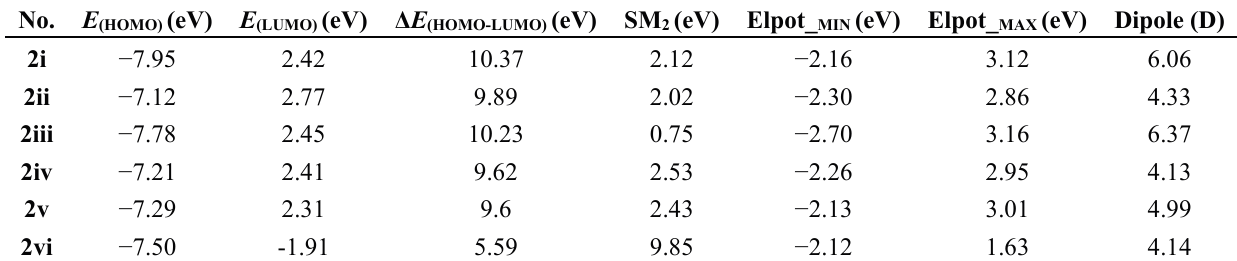
Table 3. Theoretical calculation of the properties associated with energy and charge distribution for pyrrole derivatives 2i – 2vi